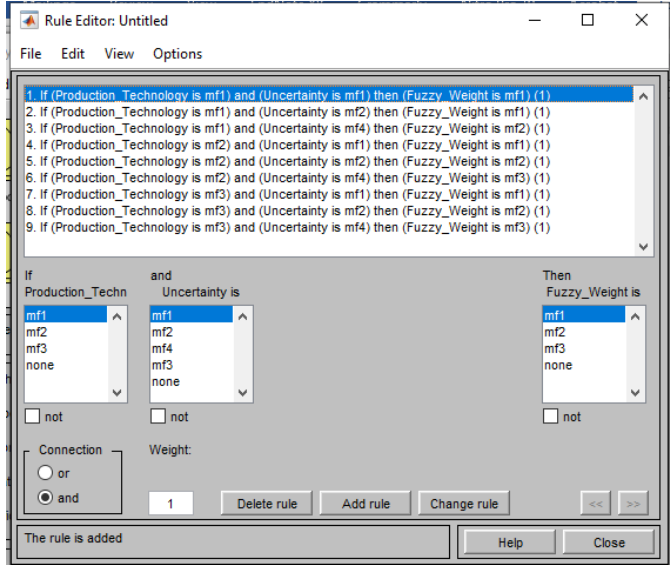
Figure 7. Rules of the developed fuzzy inference system.